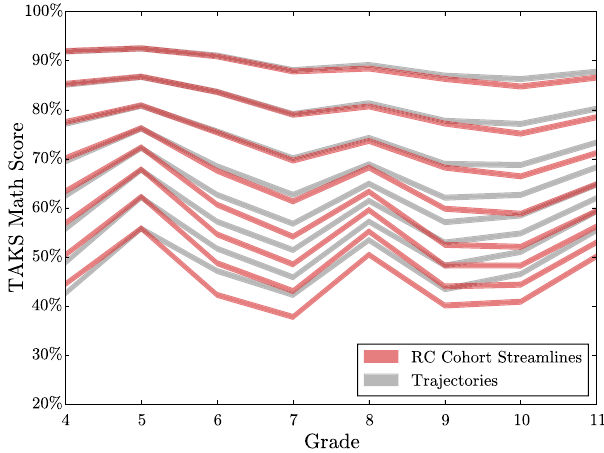
FIG. 9. RC cohort streamlines and trajectories for the cohort of 2012. The RC streamlines and the trajectories correspond very well. The slight differences are due to the students who join or leave the cohort. Before 5th grade, trajectory plots are slightly more inclusive of joiners. After 5th grade, RC cohort streamlines are more inclusive.